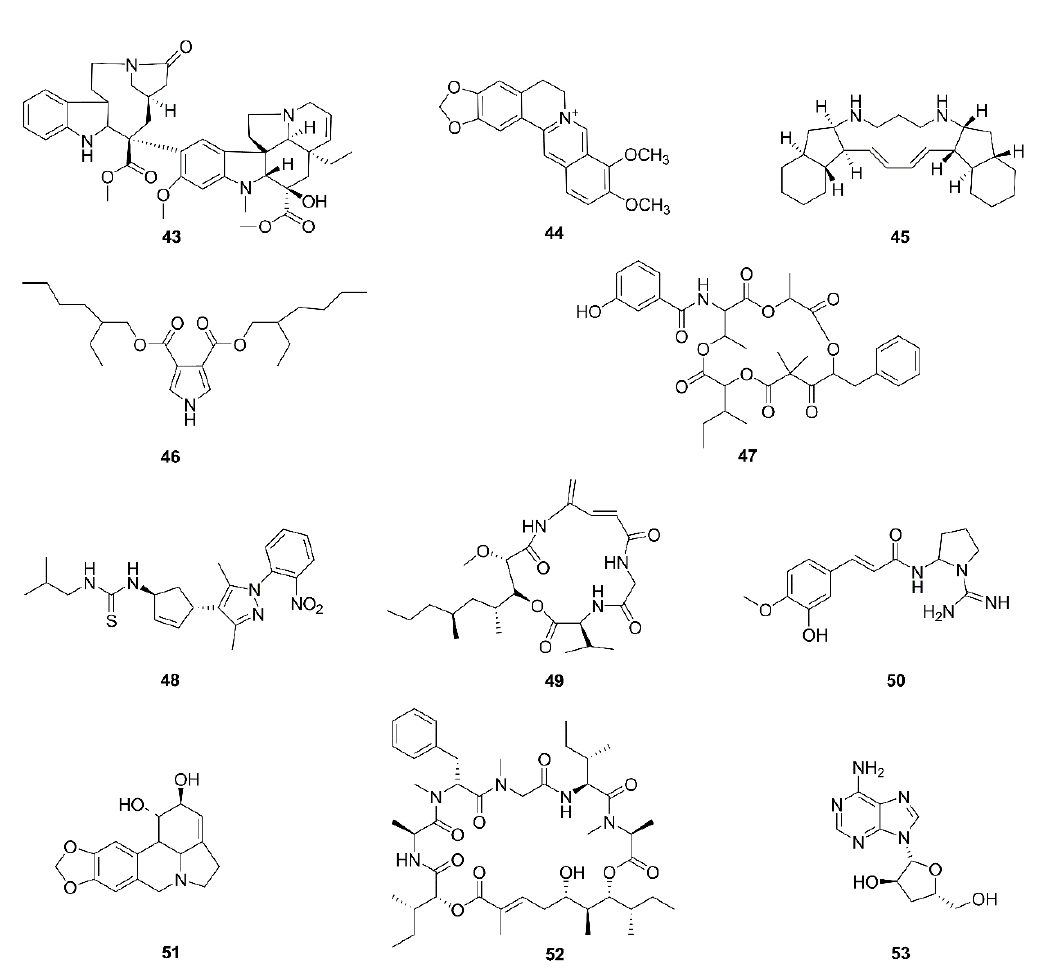
Figure 5. Chemical structures of alkaloids ( 43 – 53 ). Berberine ( 44 ), extracted from Rhizomacoptidis , has long been used as an antimicrobial agent with antitumor abilities in China [97]. In glioma cells, berberine could inhibit the aerobic oxidation and reduce the energy production efficiency of mitochondria, and reduce the metabolic activity by decreasing the activity of extracellular signal-regulated kinase 1/2 (ERK1/2). After treatment with berberine, the ridges and membrane of mitochondria were damaged, the level of ATP dropped rapidly, the ROS scavenger L -Glutathione (GSH) decreased, and NADPH decreased. The authors indicated that inhibition of ERK1/2 activity induced mitochondrial dysregulation by the reduced abundance of p-ERK after treatment of T98G cells